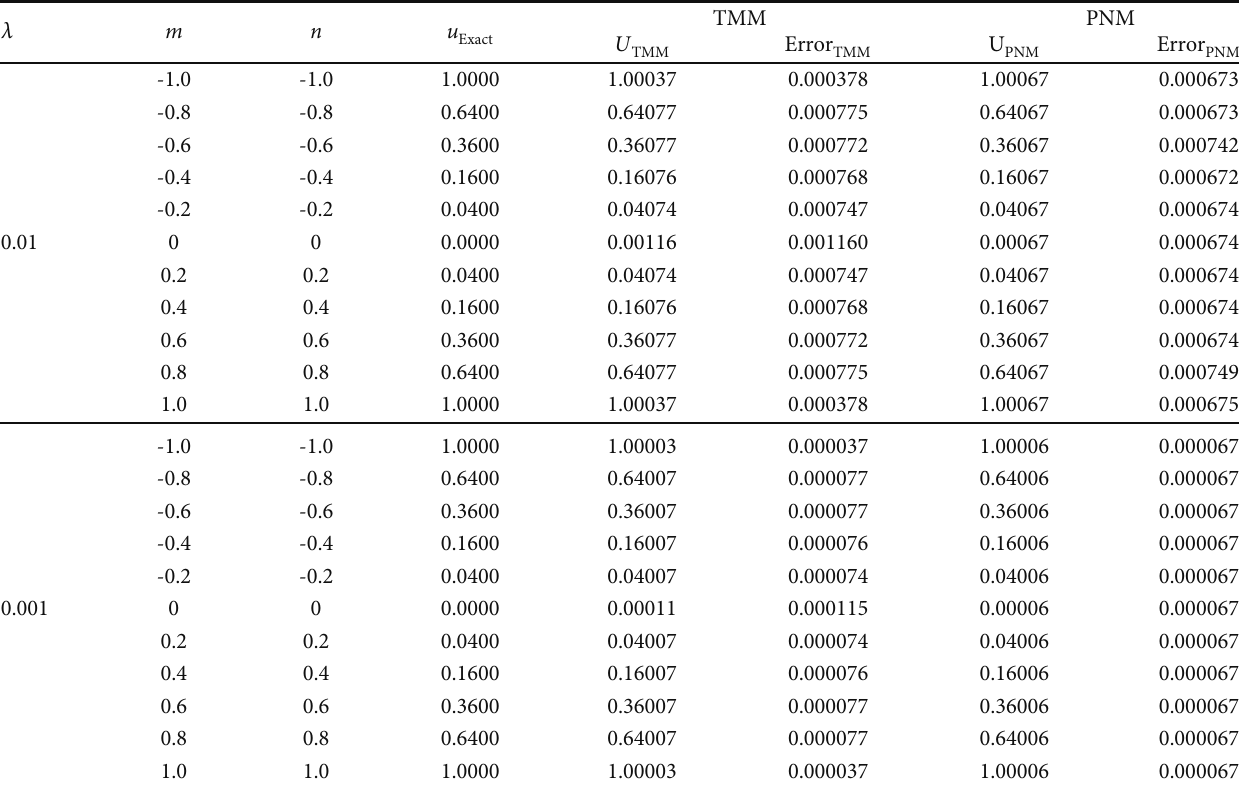
Table 3: Numerical values and absolute error values by using TMM and PNM, n = 20 , at linear case k = 1